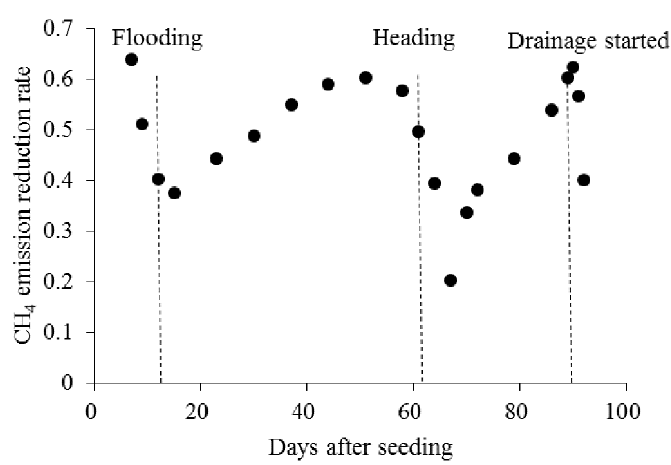
Figure 3. Reduction rate of CH